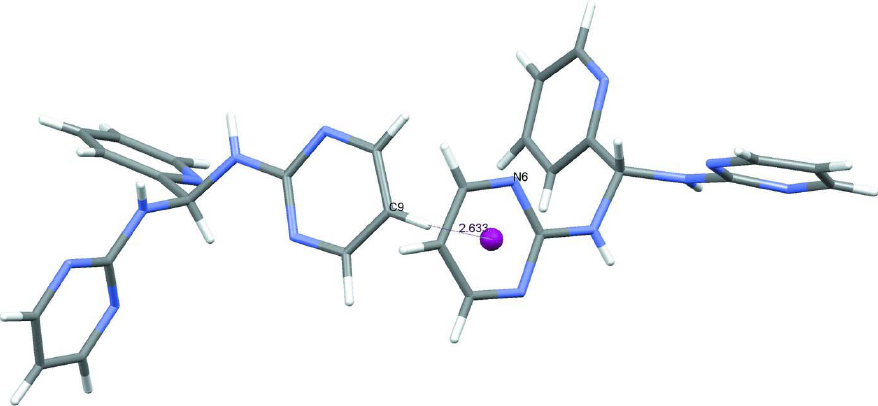
Packing diagram of (I), molecules are linked into infinite one dimensional chains by hydrogen-bond interactions (dashed lines).